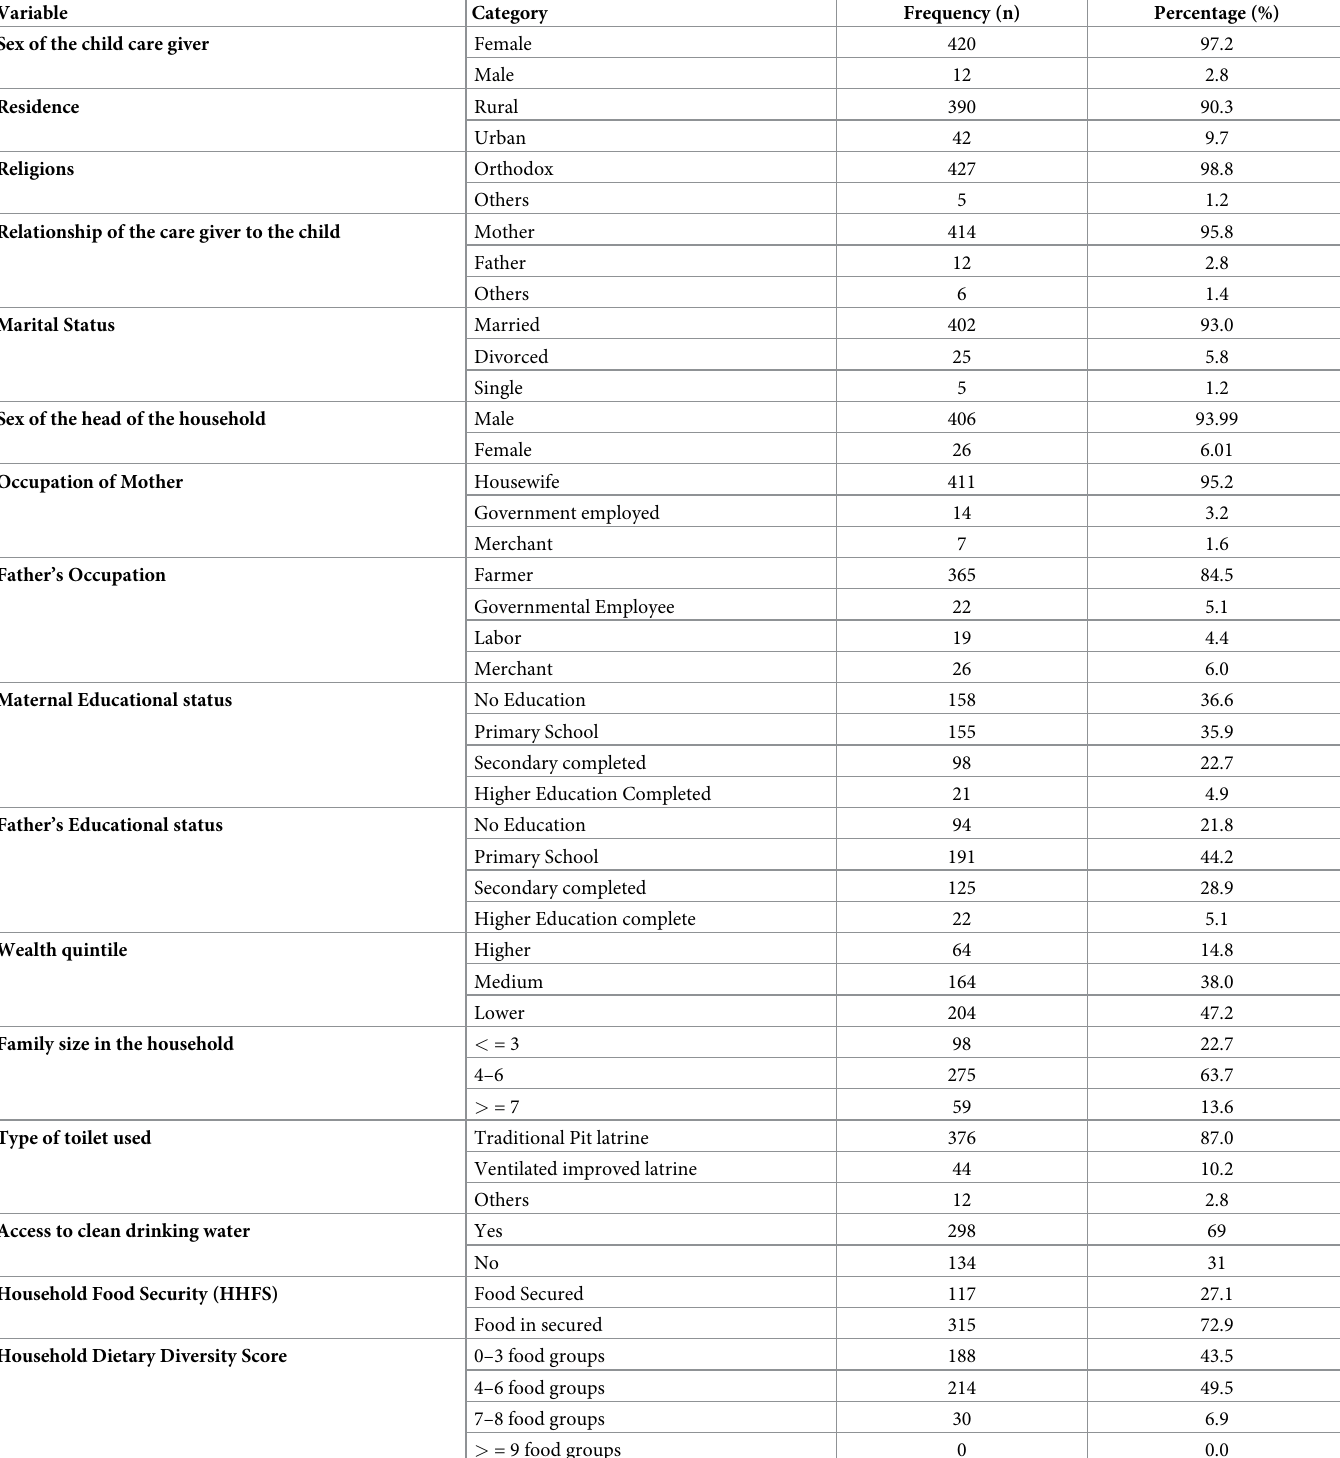
Table 2. Socio- demographic, health related and economic, characteristics of care givers in the Menz Gera Midir district Northeast Ethiopia in 2021, (N =